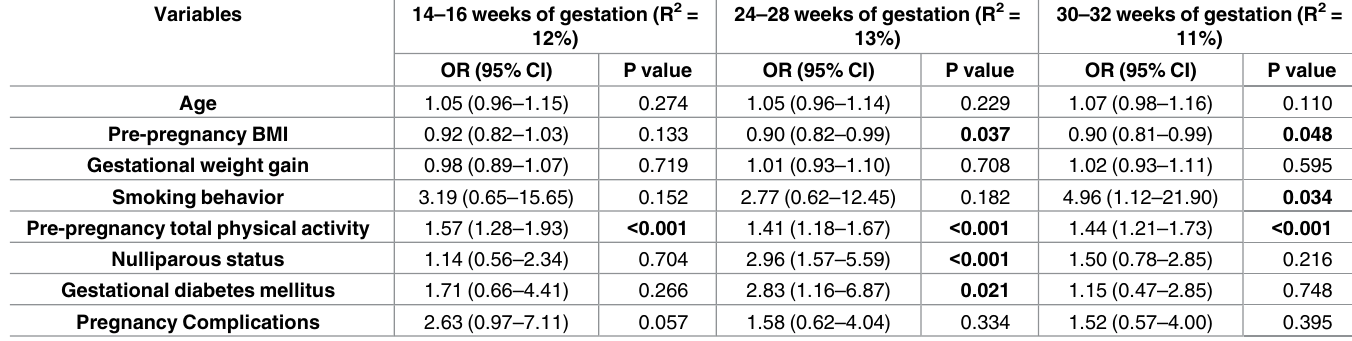
Table 3. Predictors of achieving the PA volume of at least 150 minutes/week of physical exerciseat 14–16, 24–28 and 30–32 weeks of gestation.